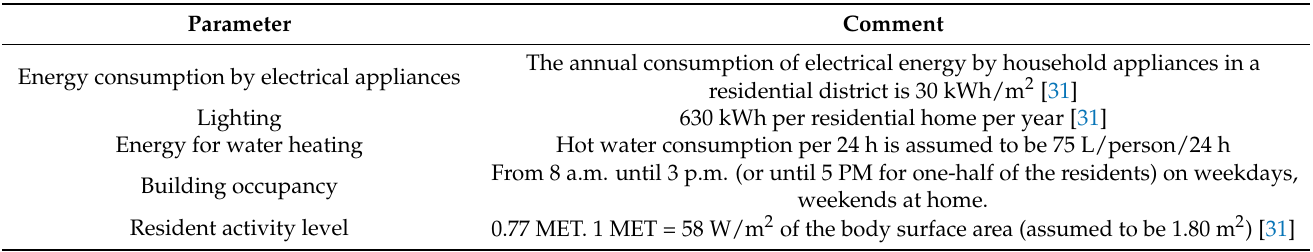
Table 6. Building usage parameters.